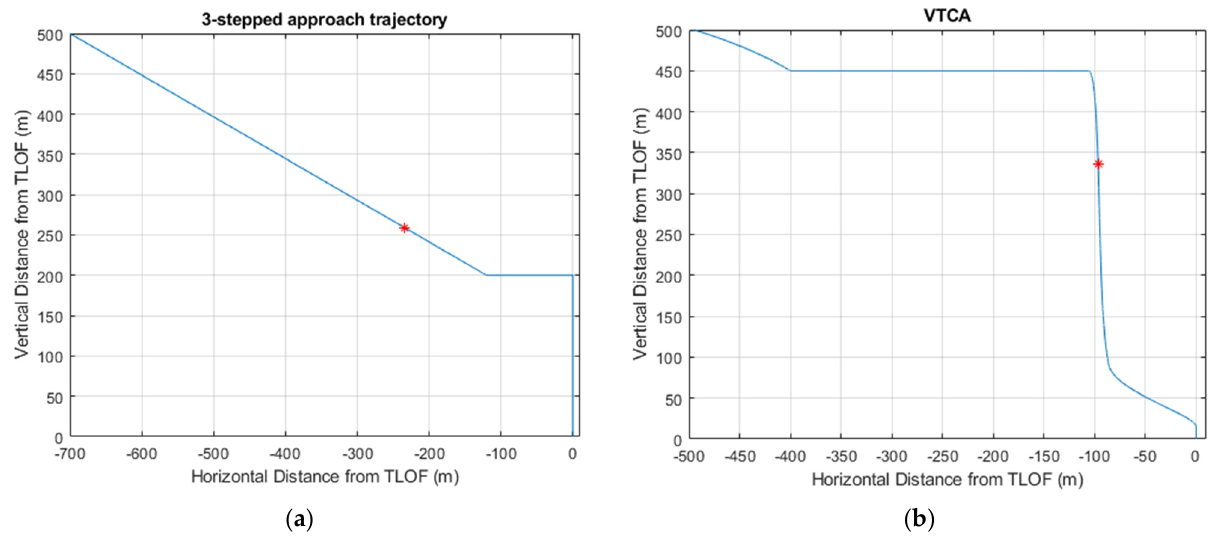
Figure 1. ( a ) 3 − stepped trajectory and selected TPVF (highlighted in red); ( b ) VTCA trajectory and selected TPVF (highlighted in red).